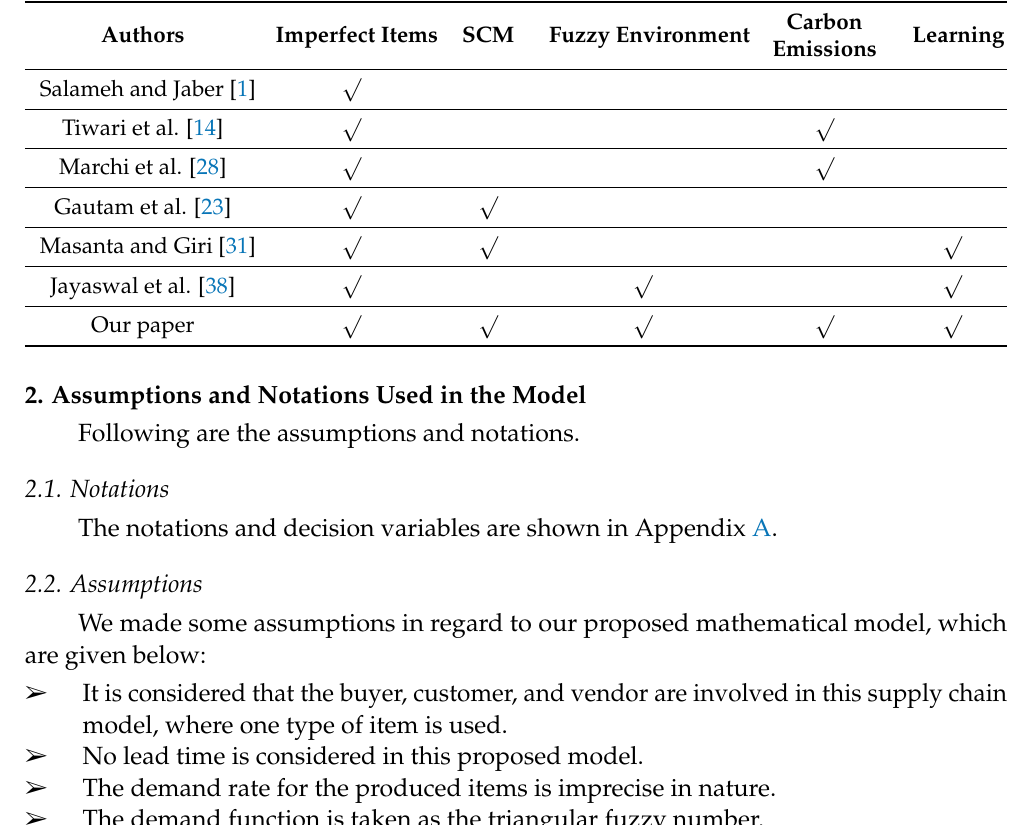
Table 1. Selected